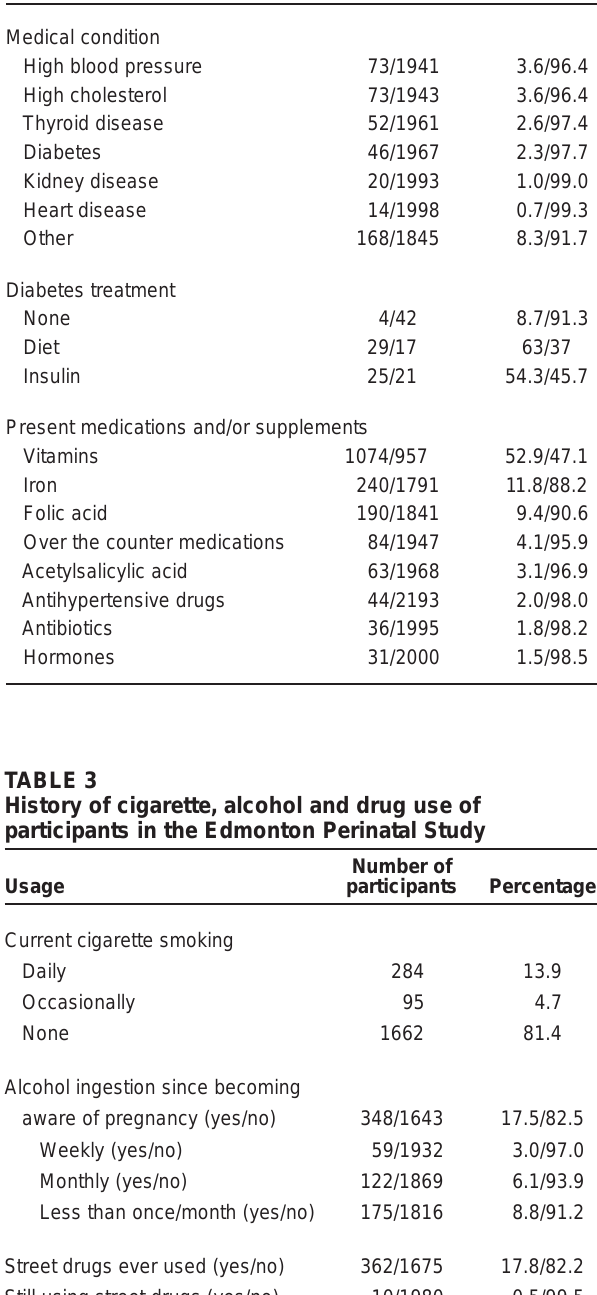
Number of participants